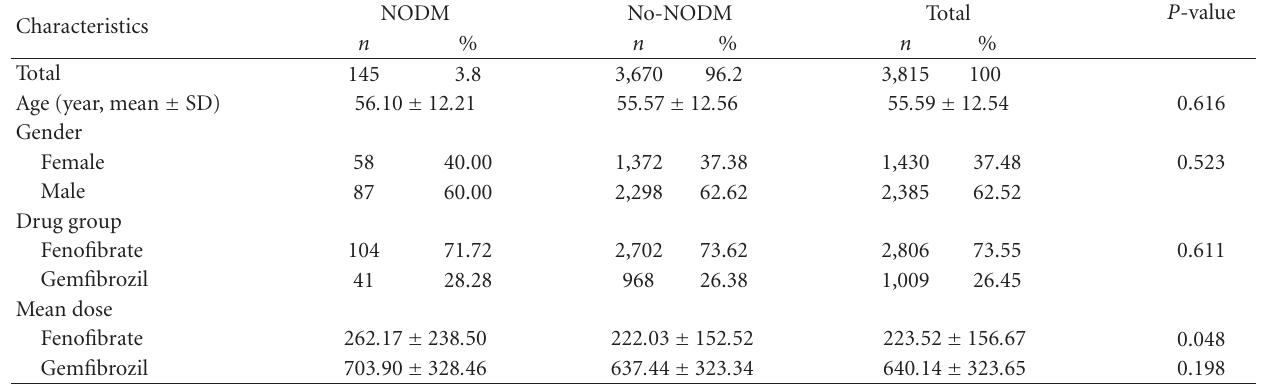
Table 1: Descriptive characteristics of fibrate prescriptions in the population, 2005–2010. Characteristics